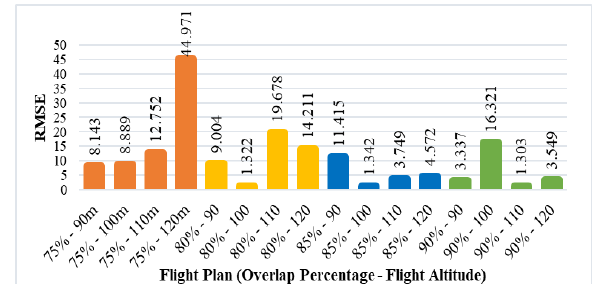
Figure 11 . Bar Graph for the visualization of flight plans based on the RMSE with respect to overlap percentage and flight